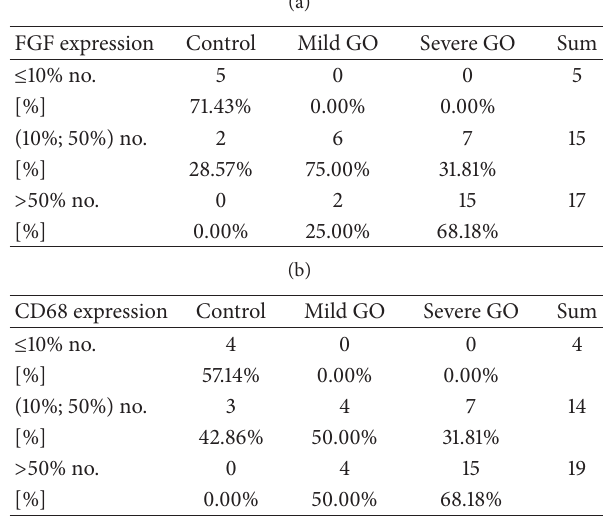
Table 3: Number of patients and the percentage of FGF and CD68 expression within scores 0, 1, and 2 in examined groups (see legend for Table